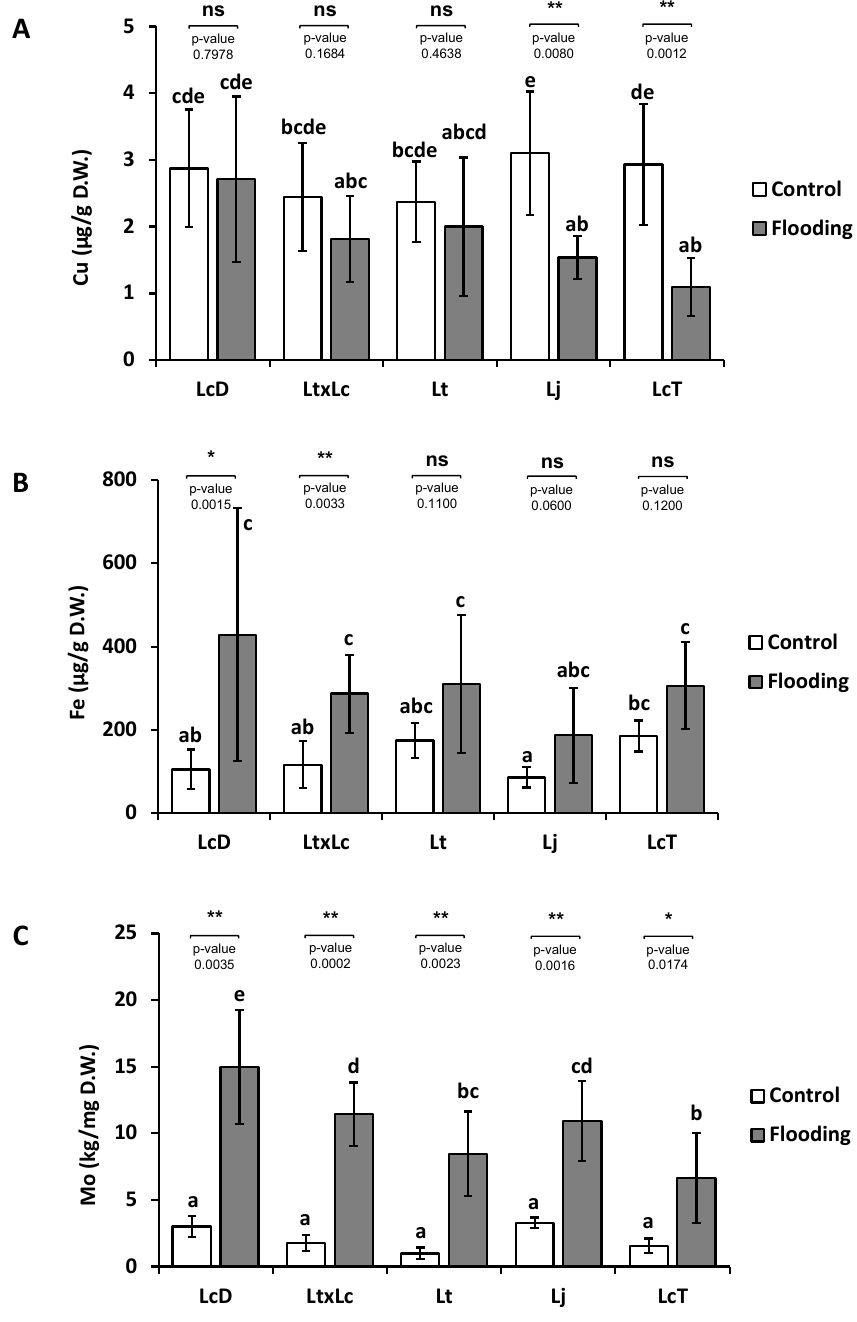
Figure 2. Endogenous Cu, Fe, and Mo concentrations in different species from the Lotus genus. Cu ( A ), Fe ( B ), and Mo ( C ) concentrations were measured from the shoots of LcD: L. corniculatus diploid. Lt: Lotus tenuis ; LtxLc: L. tenuis × L. corniculatus . Lj: L. japonicus and LcT: L. corniculatus tetraploid plants. Plants were grown under partial submergence described in Material and Methods. Values are means ± SD of six biological replicates. DW: Dry weight. Different letters above the bars represent significant differences among all the means ( P < 0.05). Between treatments for each genotypes, one asterisk ( P < 0.05) and two asterisks ( P < 0.01) over the bars mark a significant difference; ns indicate no significant difference ( P > 0.05).